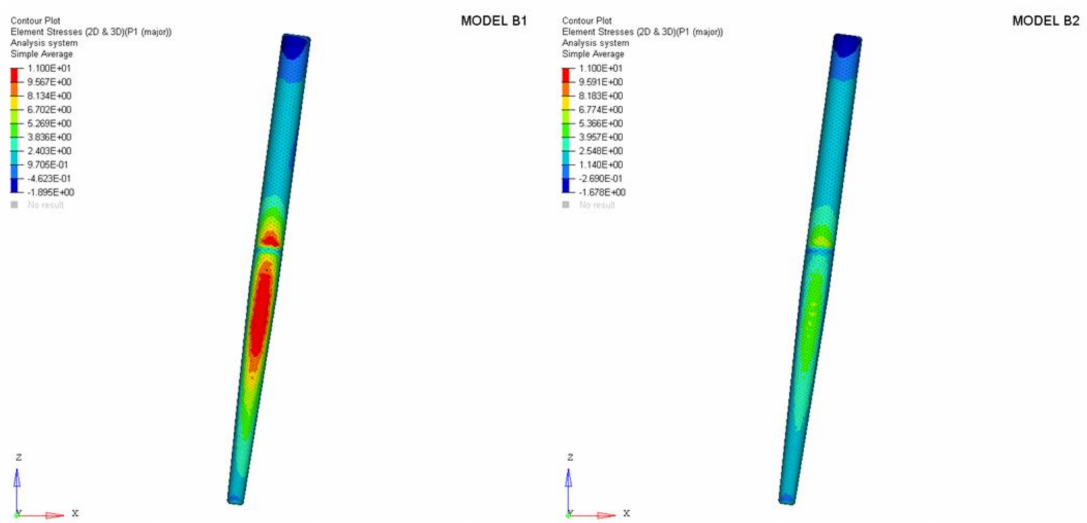
Figure 9. Models B1 and B2: Maximum principal stress distribution at the interface between the post and surrounding structures from the coronal to the apical part. The color scale was chosen to allow for comparison among the analyzed models.